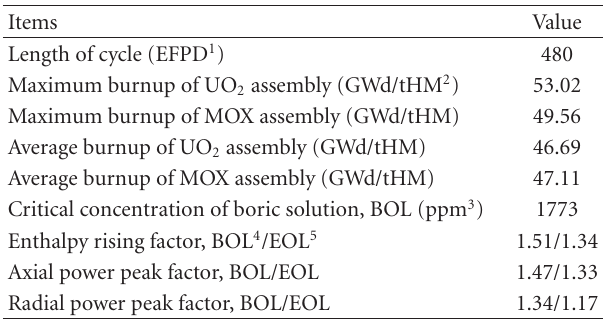
Table 2: The reactor core performance of PWR with MOX fuel loaded.